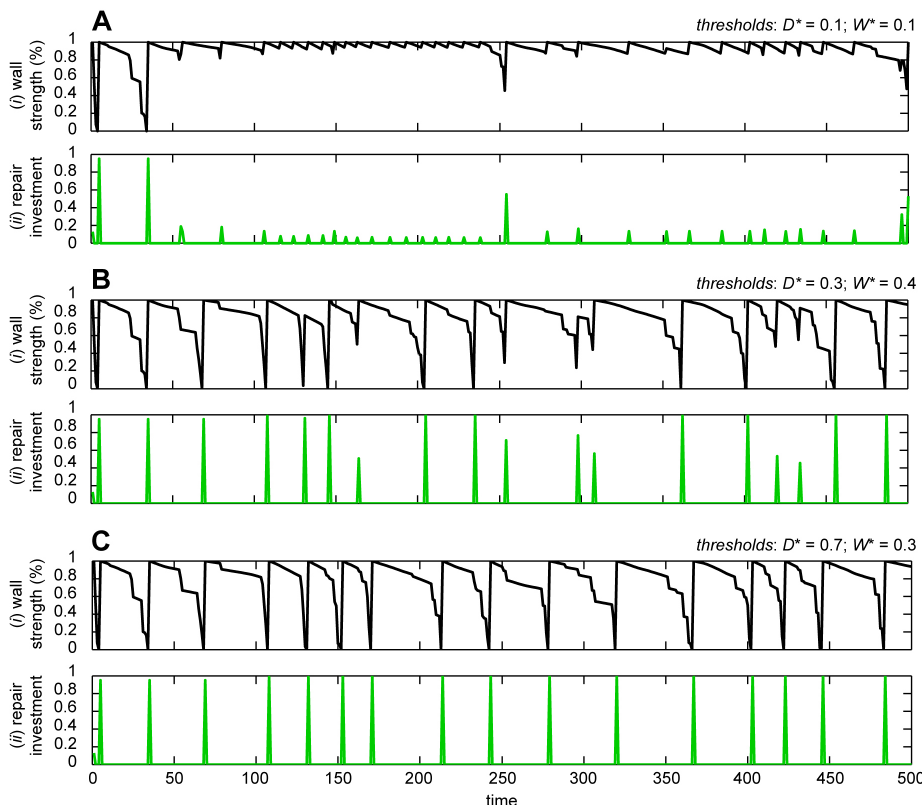
Figure 5. Time series of wall strength and repair investment for three representative pairs of threshold conditions in which: (A) thresholds for damage tolerance and economy of scale are both low ( D ∗ = 0.1 and W ∗ = 0.1), (B) both thresholds are intermediate ( D ∗ = 0.3 and W ∗ = 0.4), and (C) damage tolerance is high and the economy of scale is intermediate ( D ∗ = 0.7 and W ∗ = 0.3). In all three cases shown, N = 10